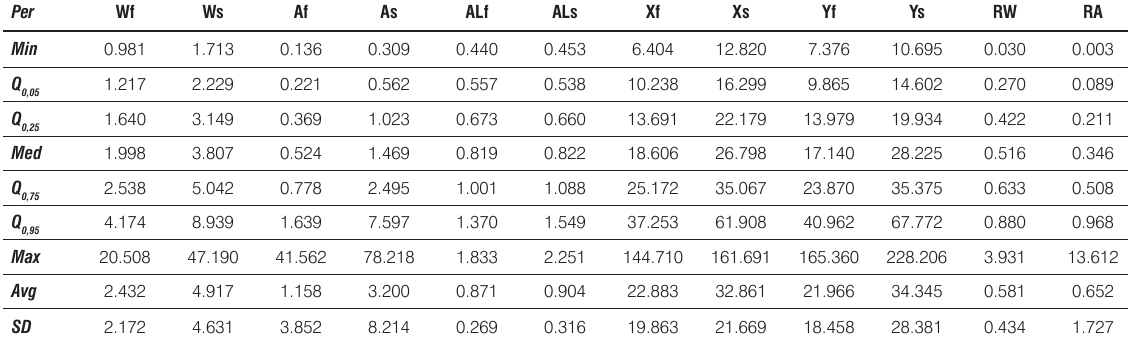
Table 3. Data distribution of observed parameters in patients with peripheral vestibular deficits.